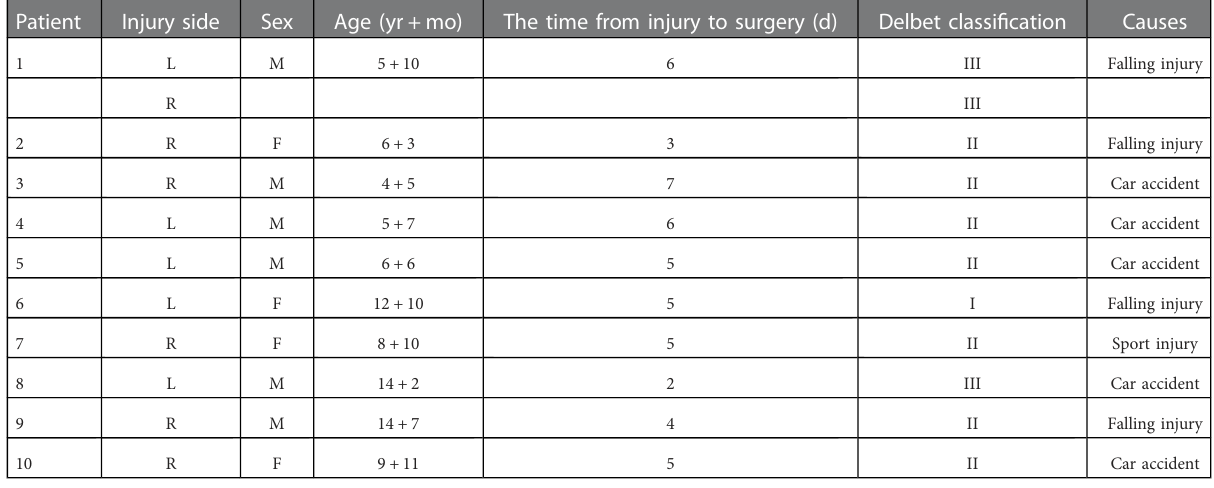
TABLE 1 Basic information of 10 children with femoral neck fracture.